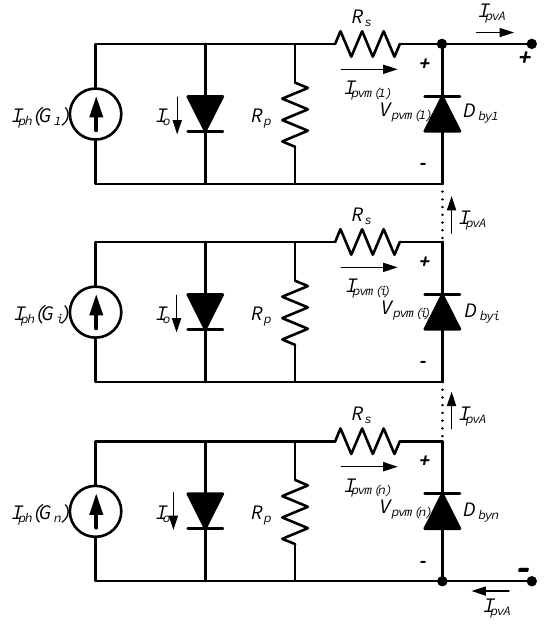
Figure 4. Array of k PV modules connected in series [36].